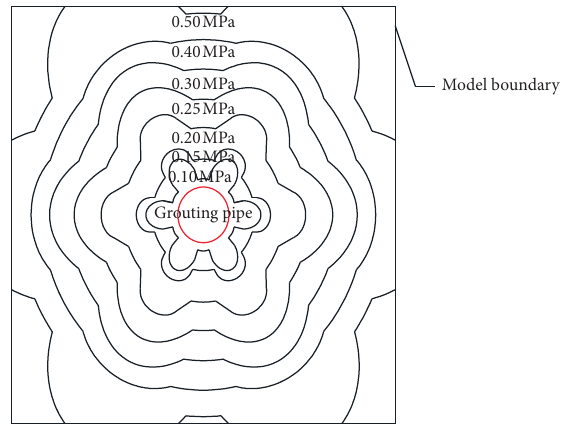
Figure 4: Extrusion zone range map for each grouting.